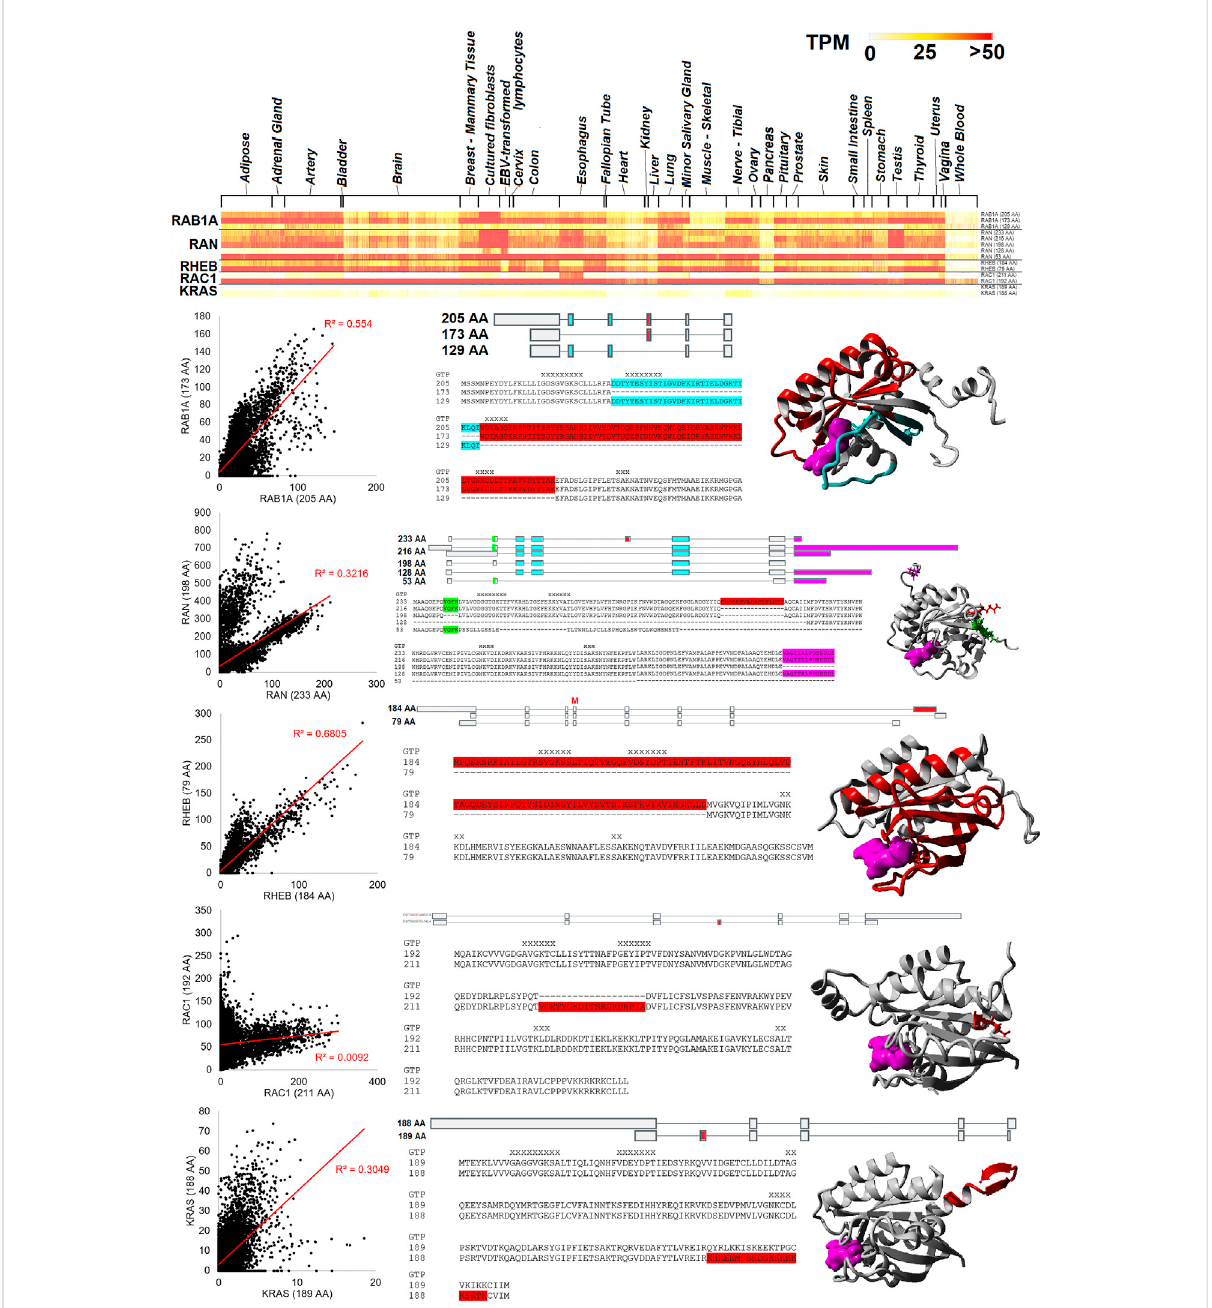
FIGURE 6 Small GTPase splicing differences seen in many tissues. The top panel shows a heat map of RAB1A , RAN , RHEB , RAC1 , and KRAS isoforms for GTEx tissues. Color is based on transcripts per million (TPM) values, where yellow is 25 TPM and red is > 50 TPM. Below the heat map are details for each of the fi ve genes. The left panel shows the values of the top protein isoforms in the 16,243 “ Blood PAXgene ” samples, where the x and y axes showdifferentisoformvalues.Theredlinerepresentsthebest fi tlinewithanR-squaredcorrelationshowninred.Themiddleshowstheisoform map and sequence alignment with variable regions identi fi ed with colors. On the far right is the protein model, with colors similar to the alignment and GTP/GDP in magenta.